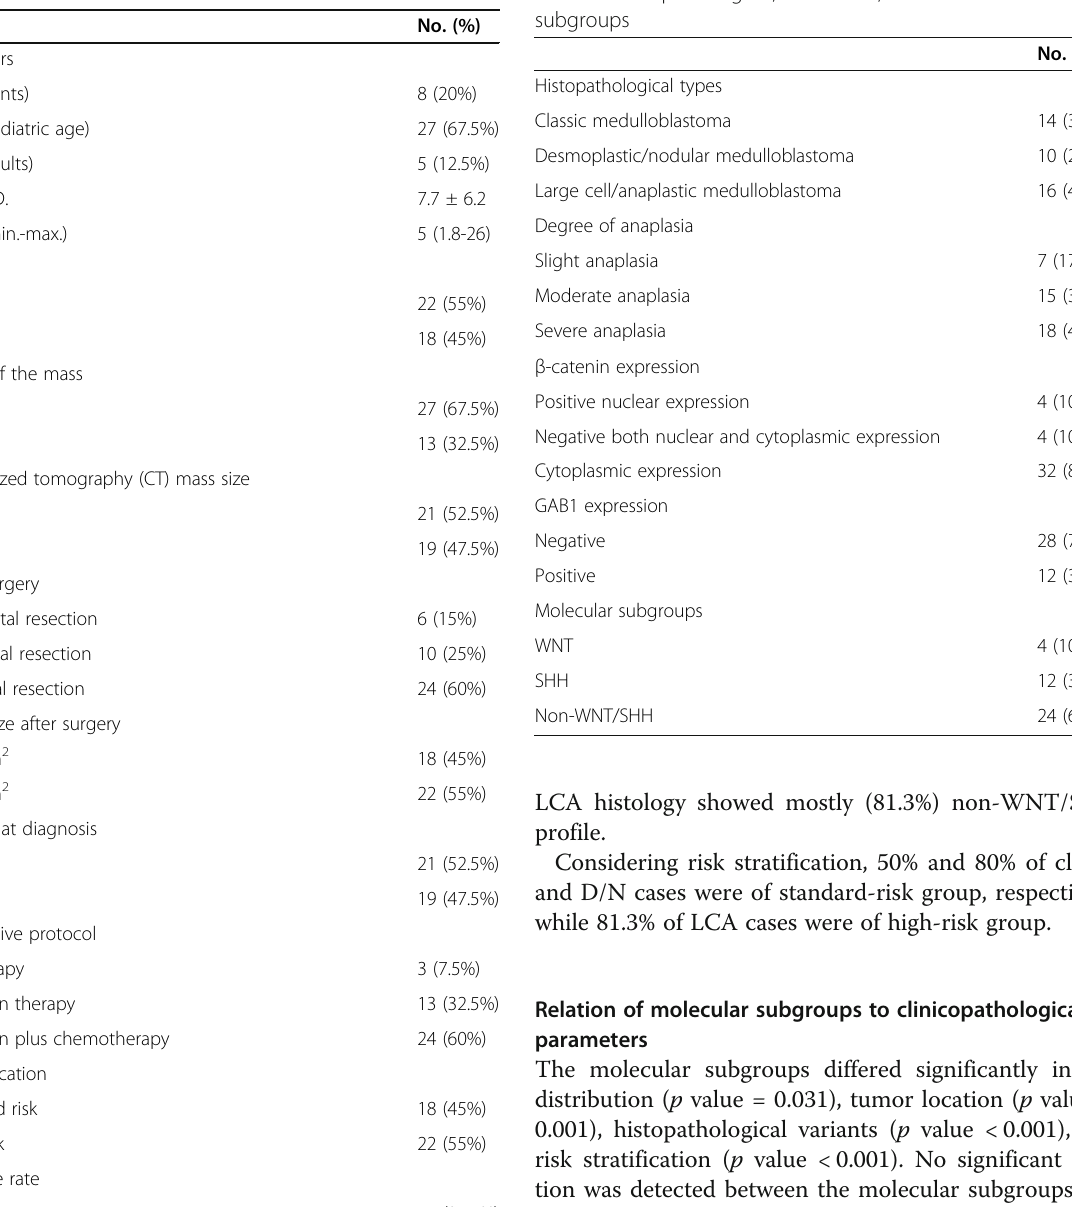
Table 1 Clinical characteristics of the studied cases Table 2 Histopathological, IHC results, and